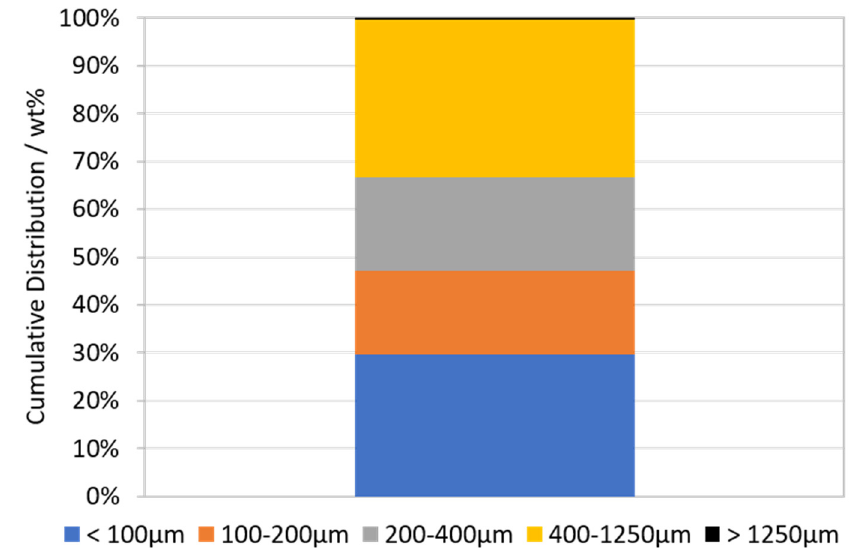
Figure 3. The mass balance of the waste LIB sieving process.